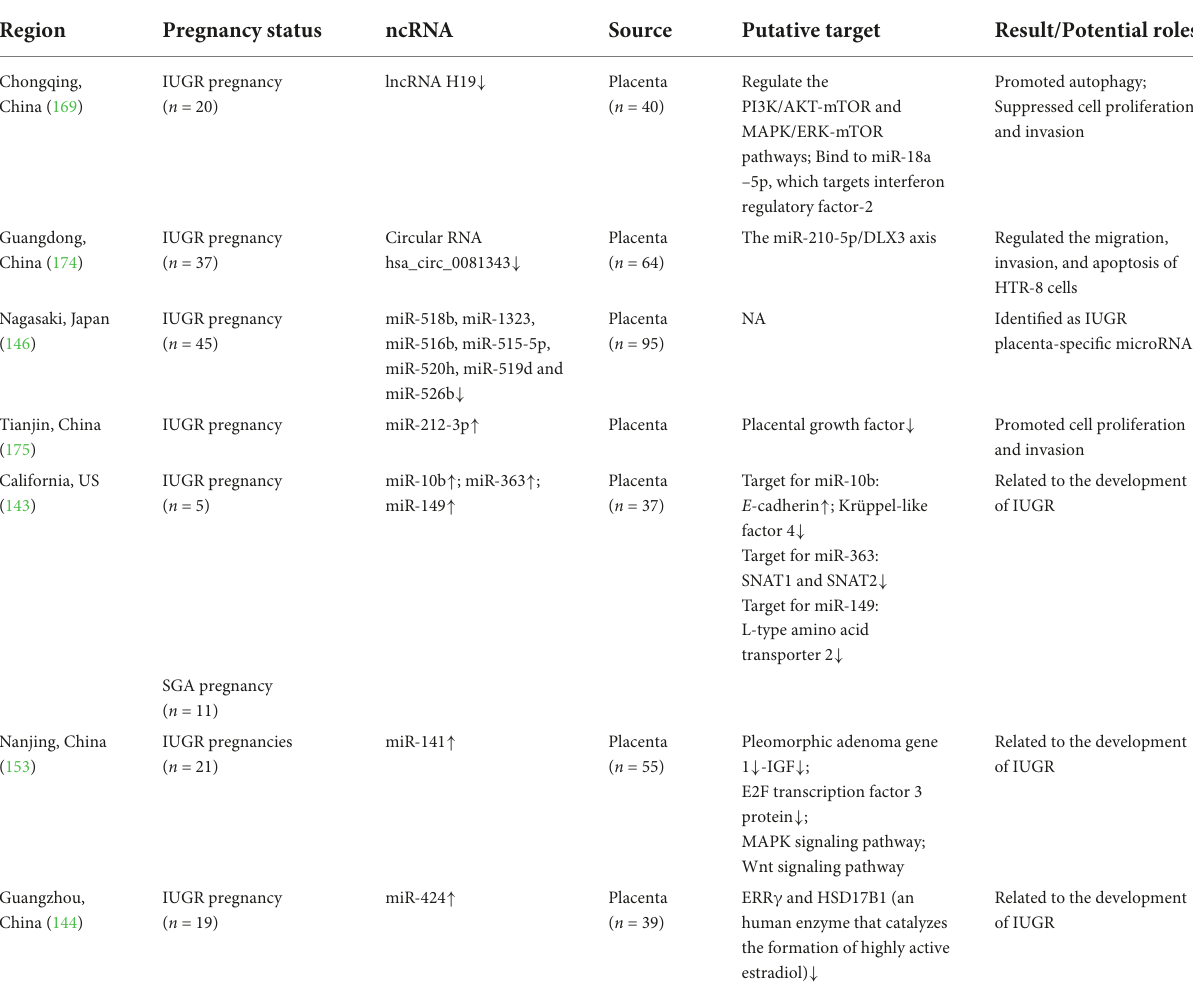
TABLE 3 Changes in ncRNA and its potential role in human IUGR